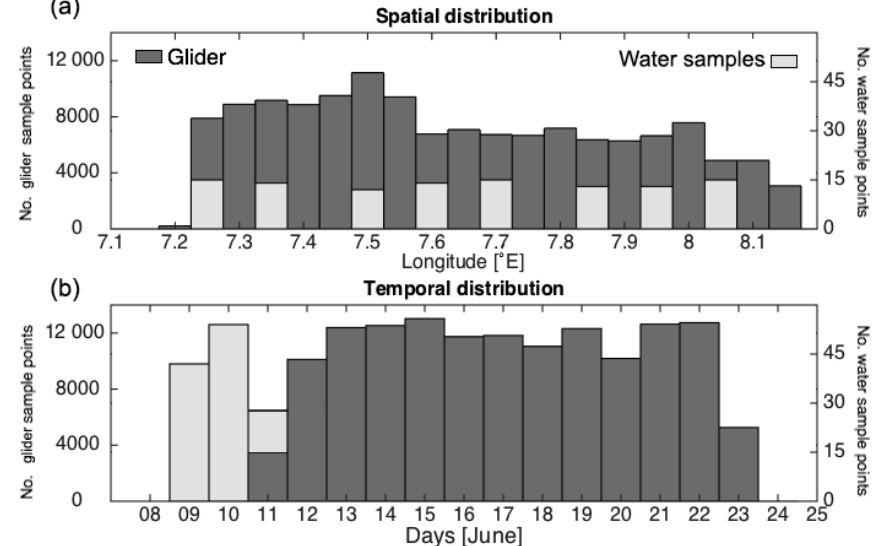
Figure 3. Histograms showing the (a) spatial and (b) temporal distribution of samples collected by the glider (dark grey) and by CTD water bottle sampling (light grey). The y axis on the left is for the sum of the glider samples, whilst the y axis on the right is for the sum of the water